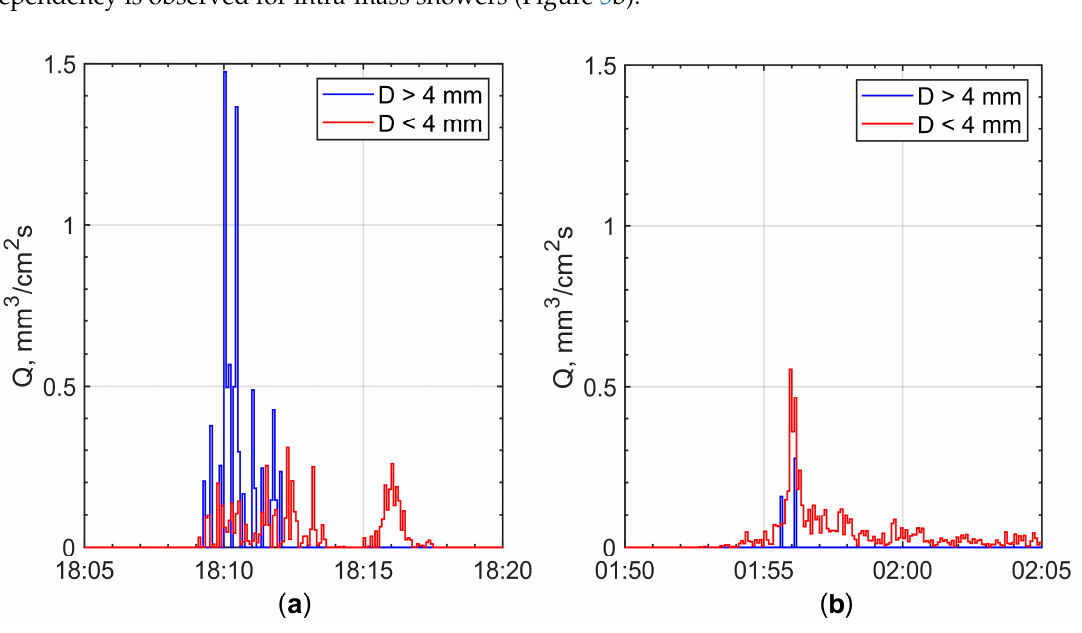
Figure 5. Rainfall volume regarding frontal heavy rain ( a ) and intra-mass shower ( b ). Here X axes represent a local time and Y axes represent an intensity of falling precipitation drops.